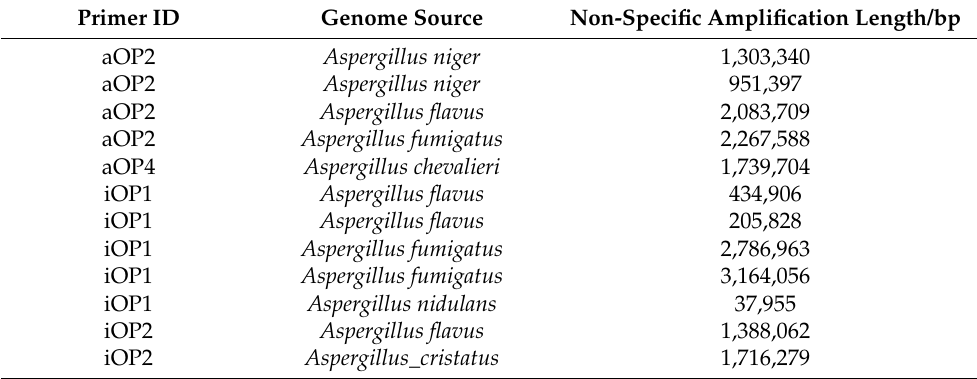
Table 3. Non-specific amplification of primers in